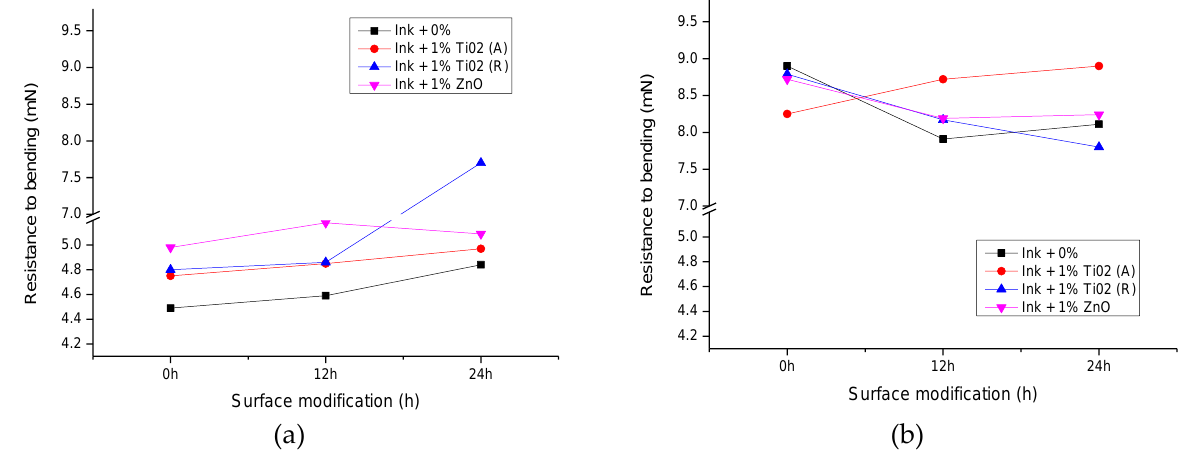
Figure 10. The resistance to bending of unmodified and modified samples with TiO 2 (A), TiO 2 (R), and ZnO nanoparticles; ( a ) uncoated and ( b ) coated paperboard.